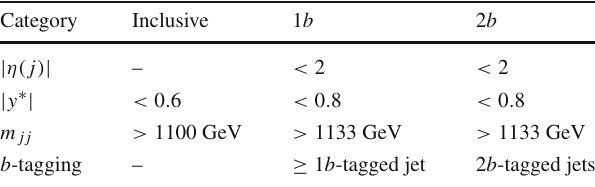
Table 3 Event selection cuts imposed on the two jets of highest p T ( j 1 and